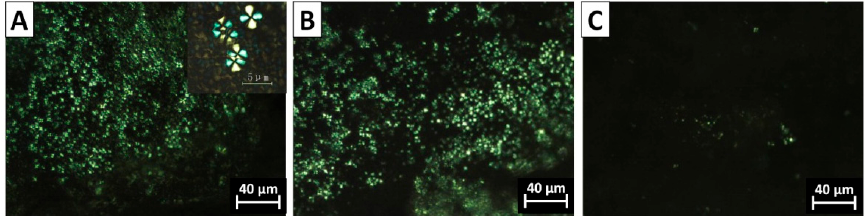
Figure 5. POM images of the PVDF/PMMA samples with the weight ratio of: ( A ) 70/30; ( B ) 60/40; and ( C ) 50/50.